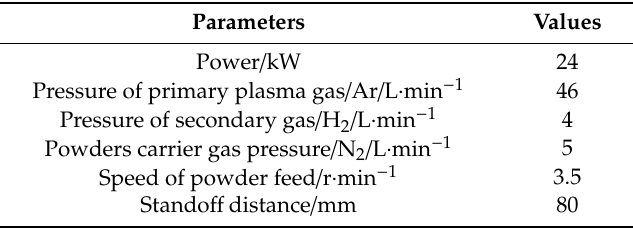
Table 1. Shrouded plasma-spray parameters.